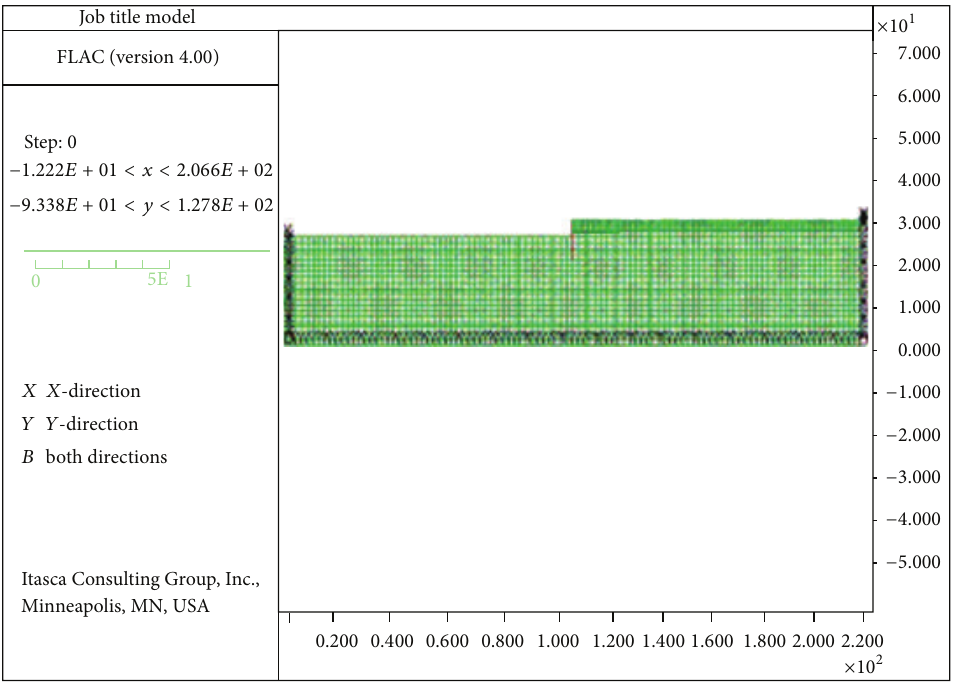
Figure 3: The selected finite difference mesh for numerical analysis by FLAC